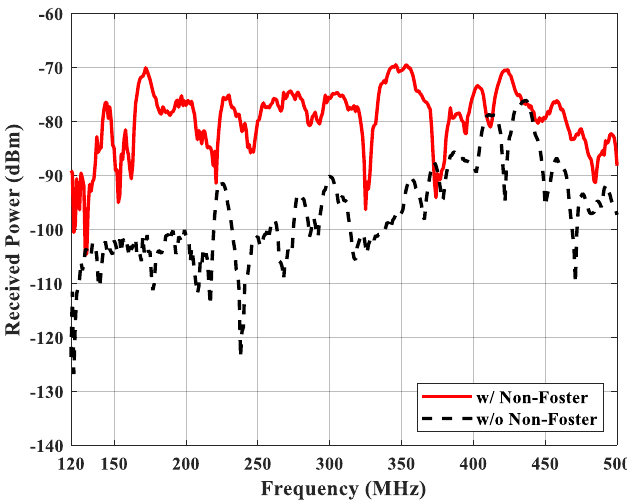
Figure 18. Measured received powers.